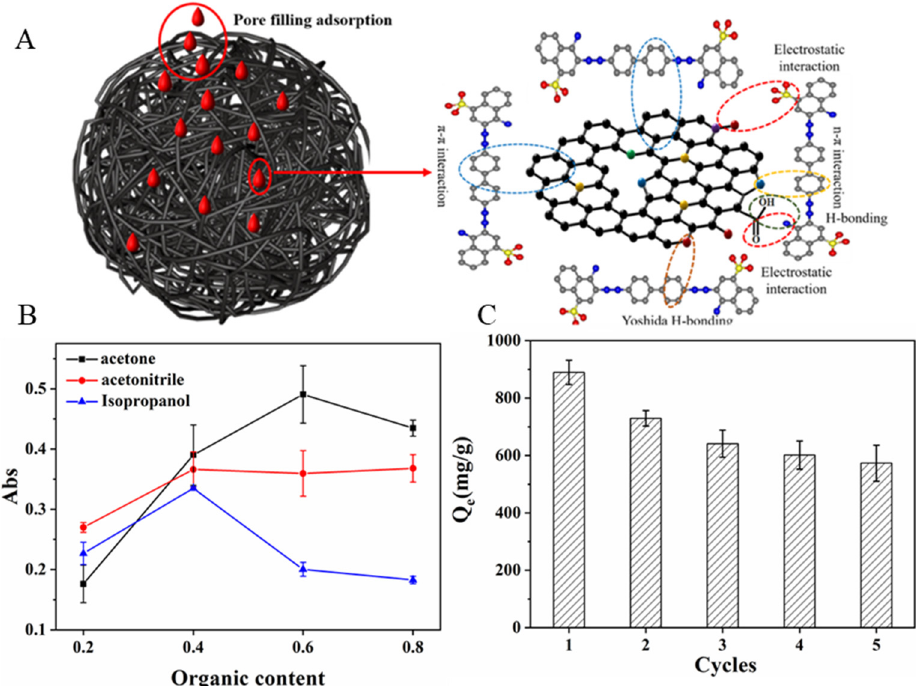
Figure 7. Possible adsorption mechanism of N-doped CM-chitin toward to CR ( A ), desorption rates of different elutant ( B ), and reusability of N-doped CM-chitin (10 mg) for adsorpiton of CR (200 mg L − 1 ) at 298.15K (C).